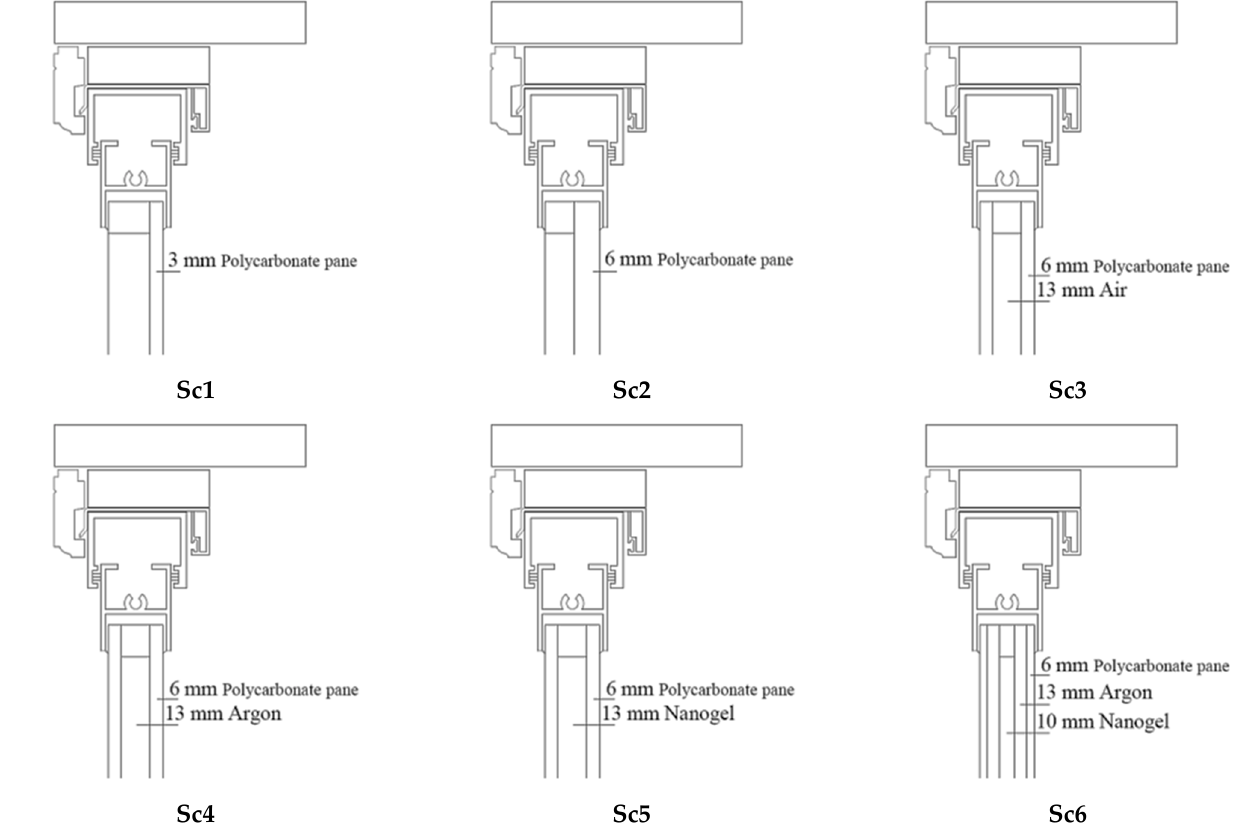
Figure 5. Cross sections of windows.